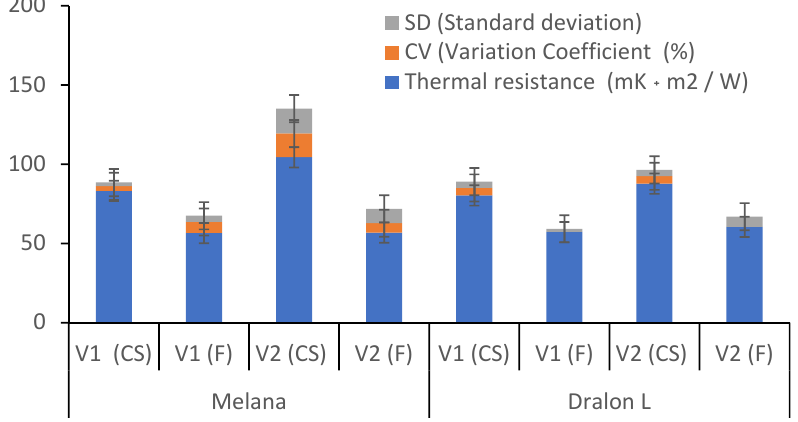
Figure 13. Influence of the functionalization treatment on the thermal resistance of two knitted fabric variants (V1 and V2) with acrylic fibers Melana and Dralon L. (abbreviation: CS = control sample; F = functionalization).